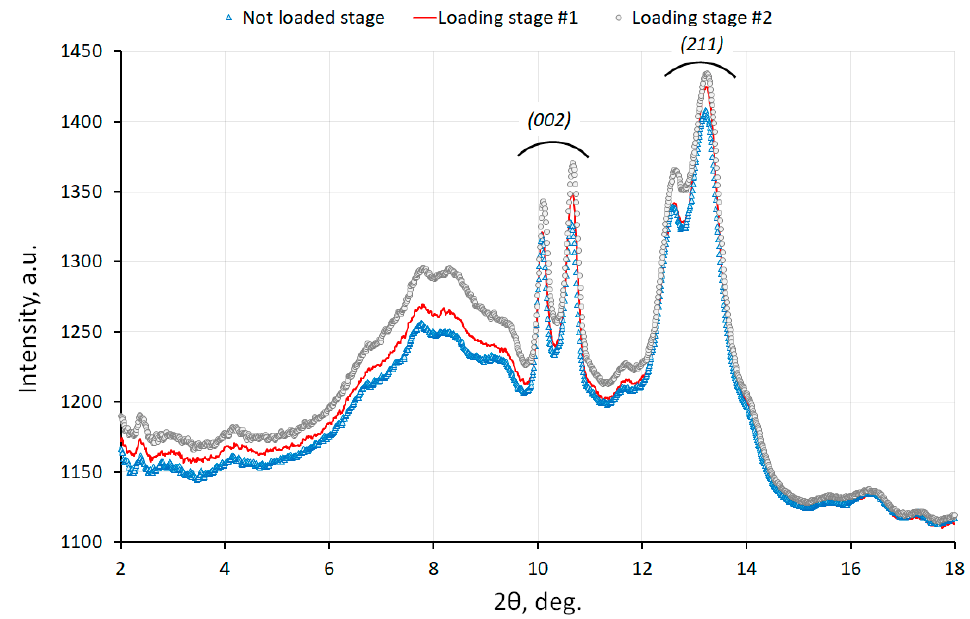
Figure 5. Equivalent 1D profiles at various stages of bone loading [18].